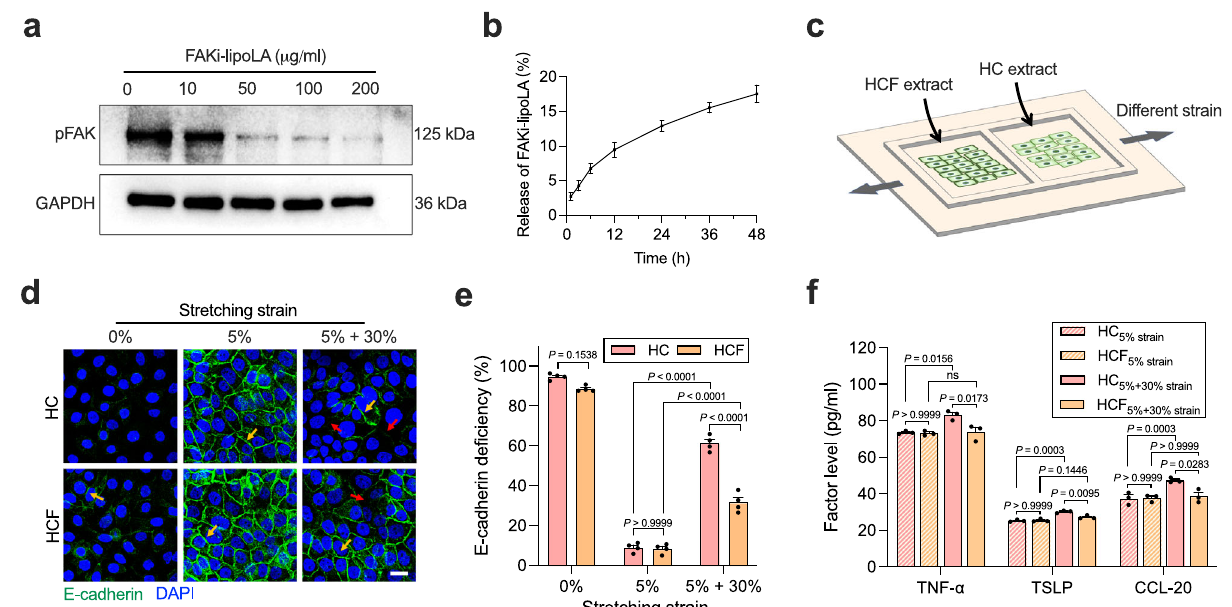
Fig. 5 | Inhibition of FAK protects cells from mechanical damage in vitro. a WesternblottingresultsofpFAKinhibitioninHaCaTcellsbyFAKi-lipoLA. b Time- related FAK-lipoLA release from HCF hydrogels placed in a transwell. Data are shown as mean±s.d. c Schematic diagram of cell stretching experiment. d Fluorescent staining of HaCaT cells after stretching with E-cadherin (green) and